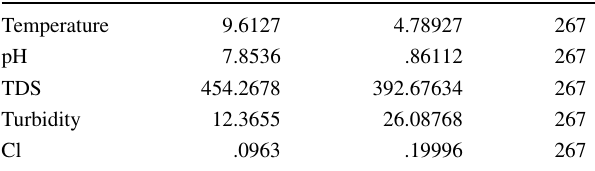
Table 2 Mean values of environmental parameters